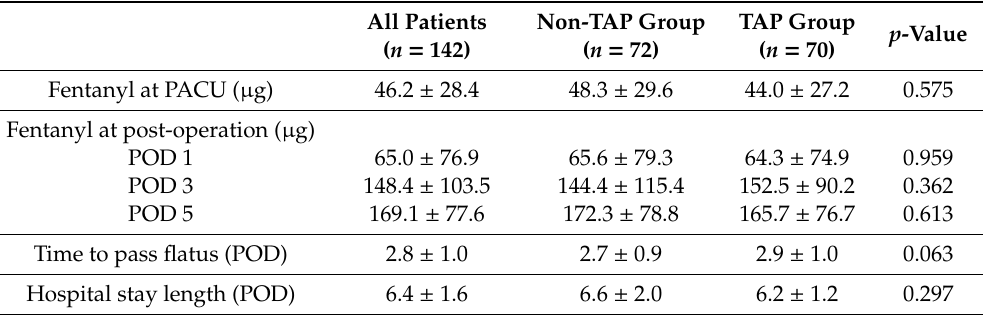
Table 4. Postoperative characteristics.